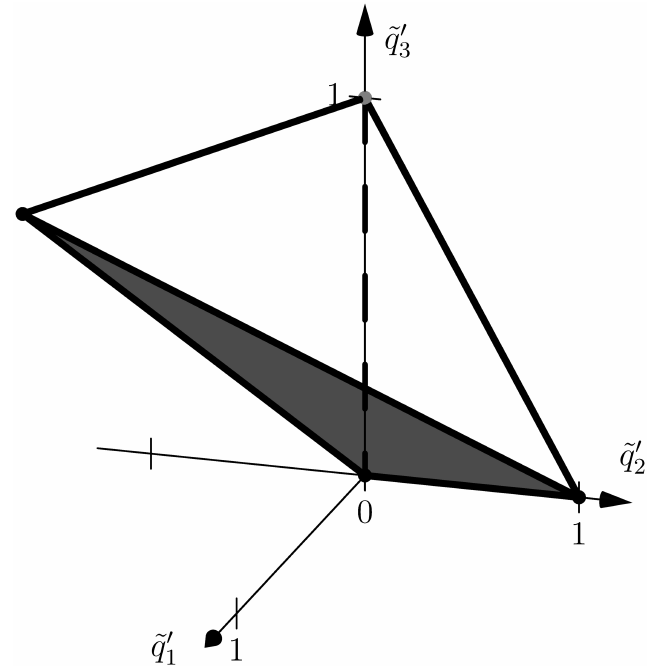
Figure 3. The polyhedron Γ ( f 2 ) of the second equation of the system (11). The selected face corre- sponds to the second equation of the truncated system